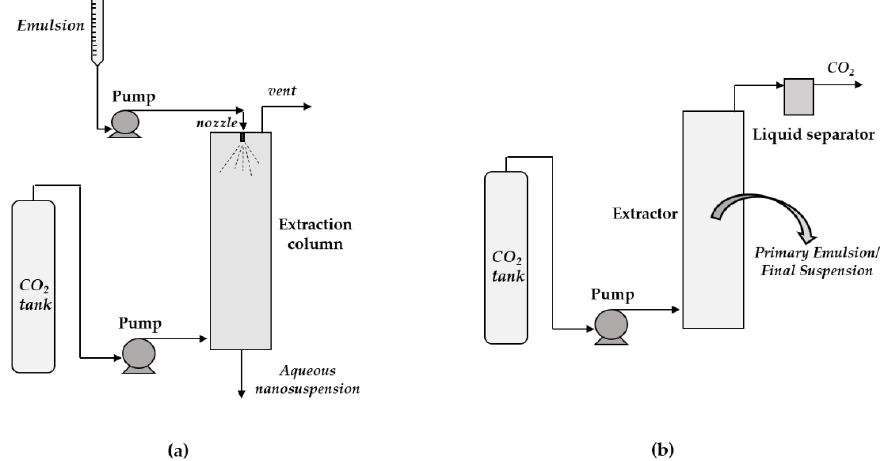
Figure 6. A sketch of the Supercritical fluid extraction of emulsions (SFEE) technology: ( a ) continuous and countercurrent SFEE; ( b ) batch SFEE.